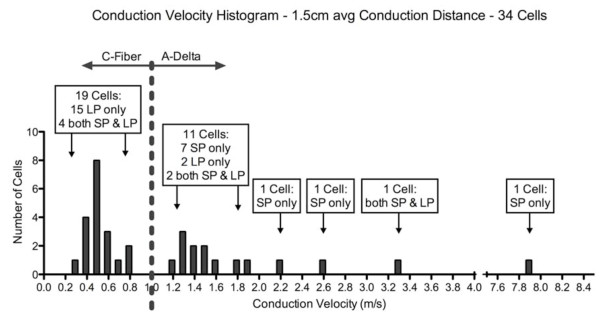
Distribution of Conduction Velocities of Recorded Neurons. Number of afferents along the spectrum of conduction velocities, determined using delay to response to electrocutaneous stimulation of receptive fields are shown, along with the response specificity of those afferents.